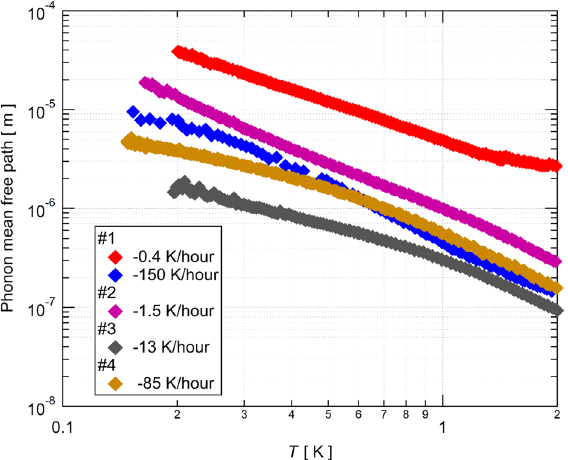
Figure 4. The temperature dependence of the phonon mean free path. See the main text for